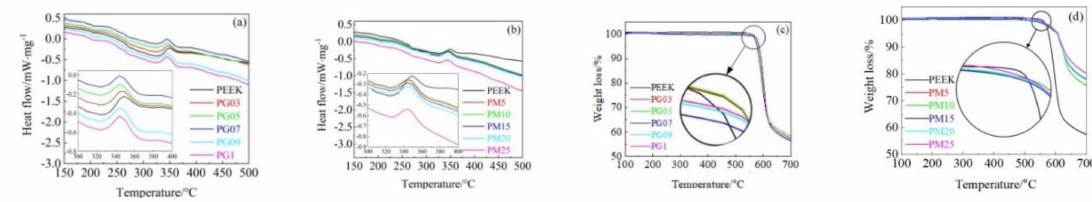
Figure 8. DSC and TGA curves of ( a , b ) PEEK and PEEK / GOs and ( c , d ) PEEK and PEEK /